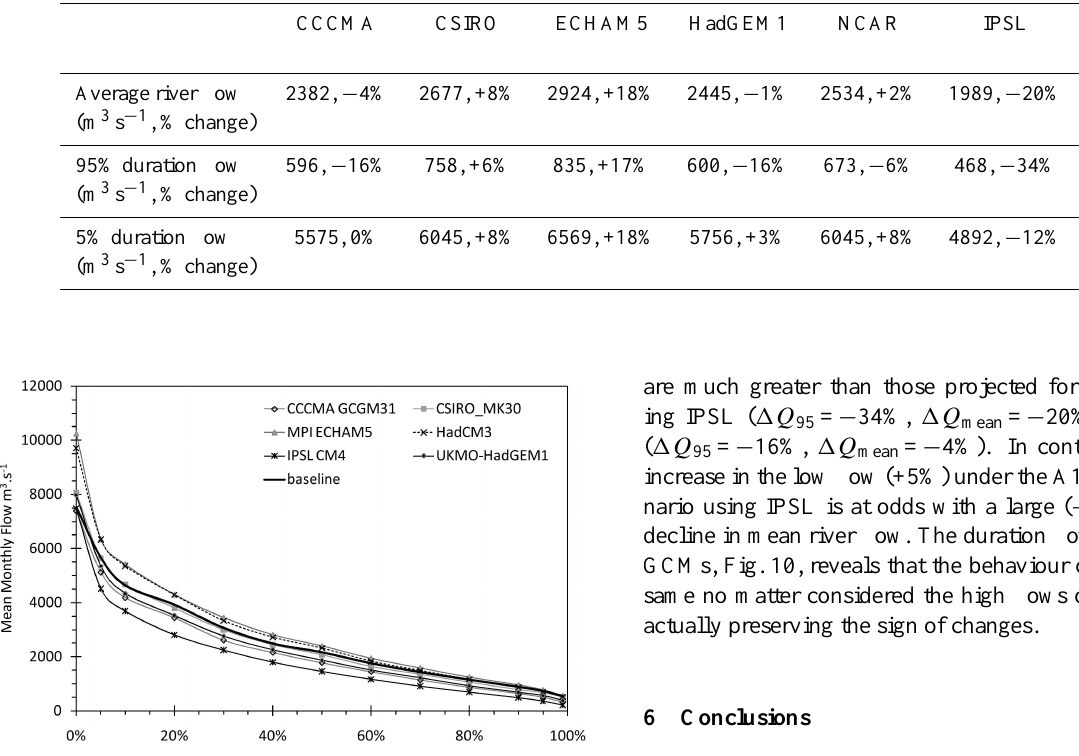
Table 6. Hydrological modelling results using the same mean global temperature rise scenario (+2 ◦ C) and projections from different global circulation models. Control run was calculated using 30 years, from 2040 to 2069.